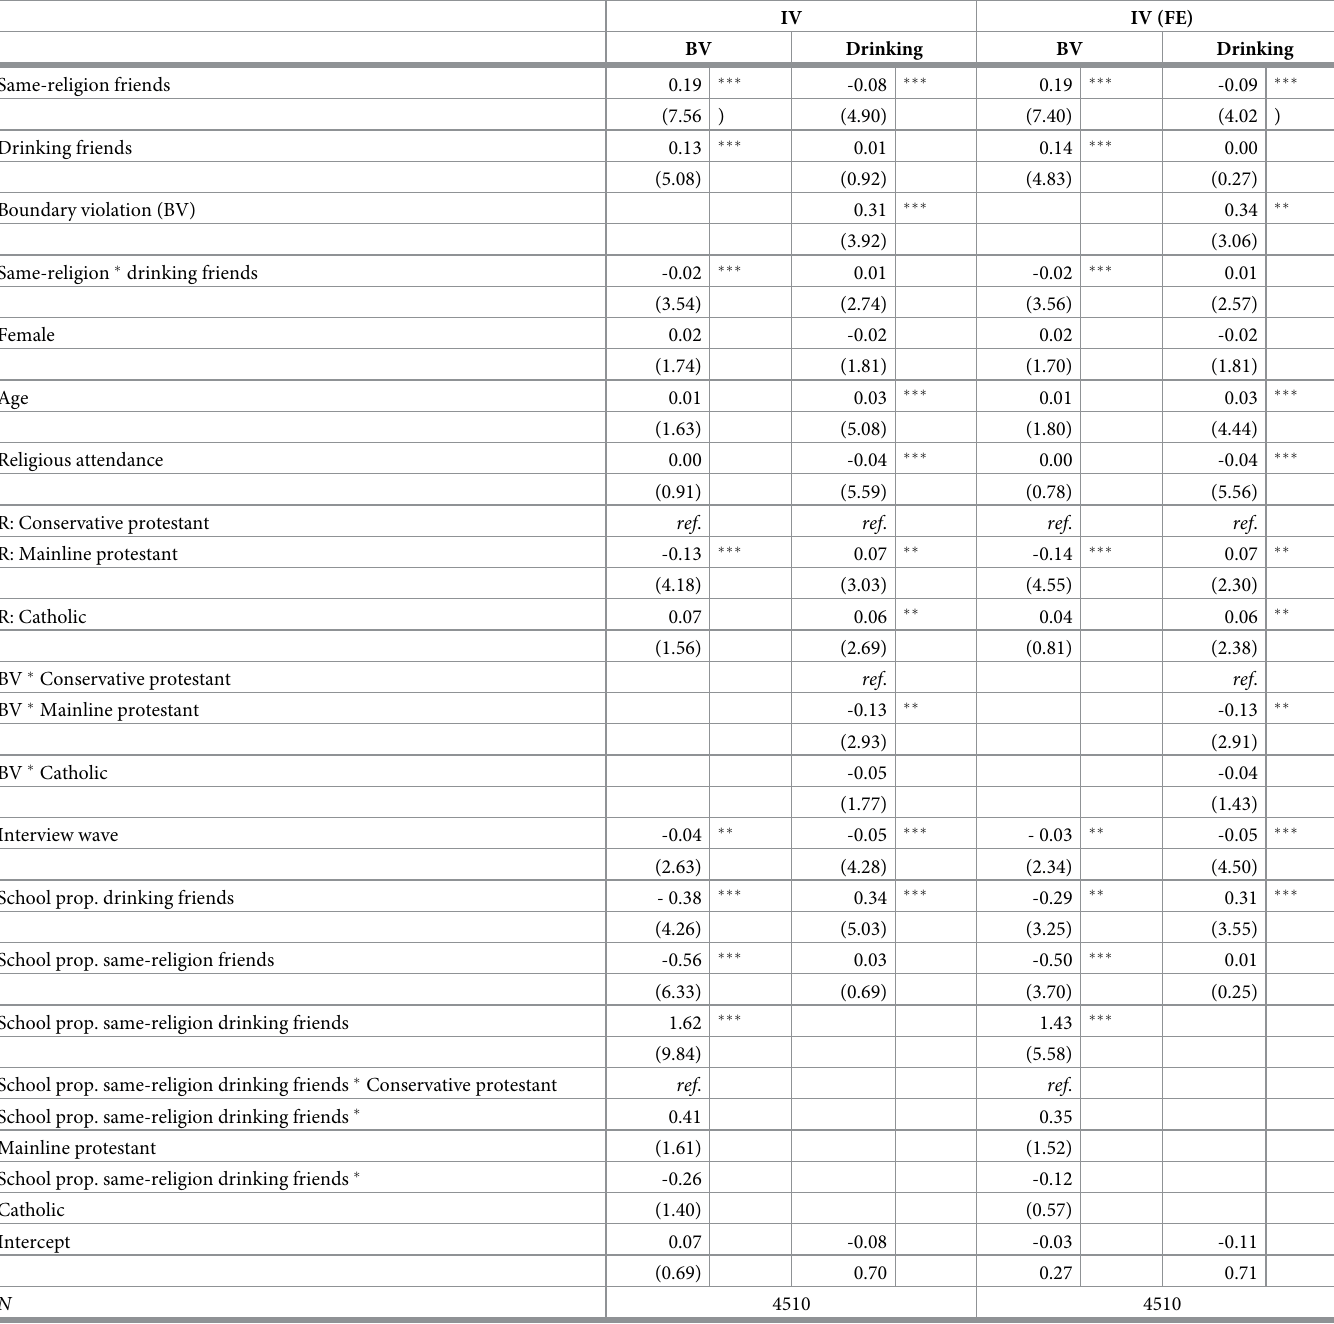
Table 3. Two equations linear probability model of drinking and of boundary violation instrumented by the school proportion of same-religion drinking friends. Drinking